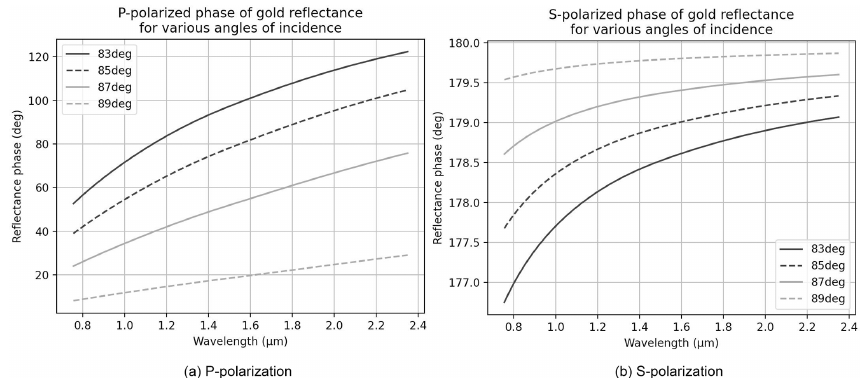
Figure 4. Phase shift at reflection on a thick gold layer, computed from Raki´c gold index parametrization (Raki´c et al., 1998) with definitions of polarization axes from Macleod (2017). (a) P polarization (P-pol), (b) S polarization. The 180 ◦ shift in P-pol discussed in Fig. 5 is not included.